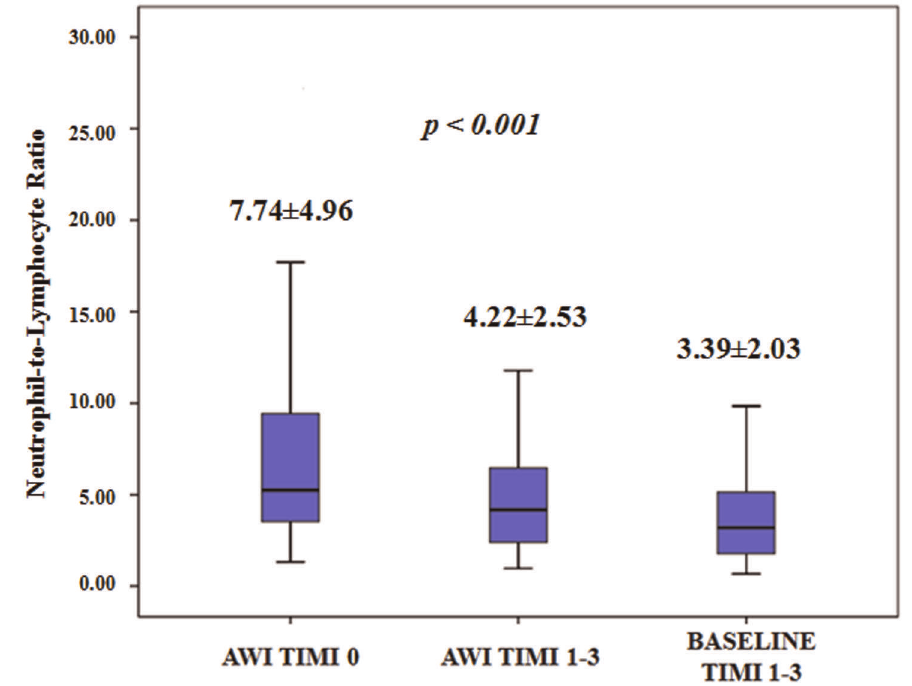
Figure 1 - Comparison of neutrophil-to-lymphocyte ratio (NLR) values among the